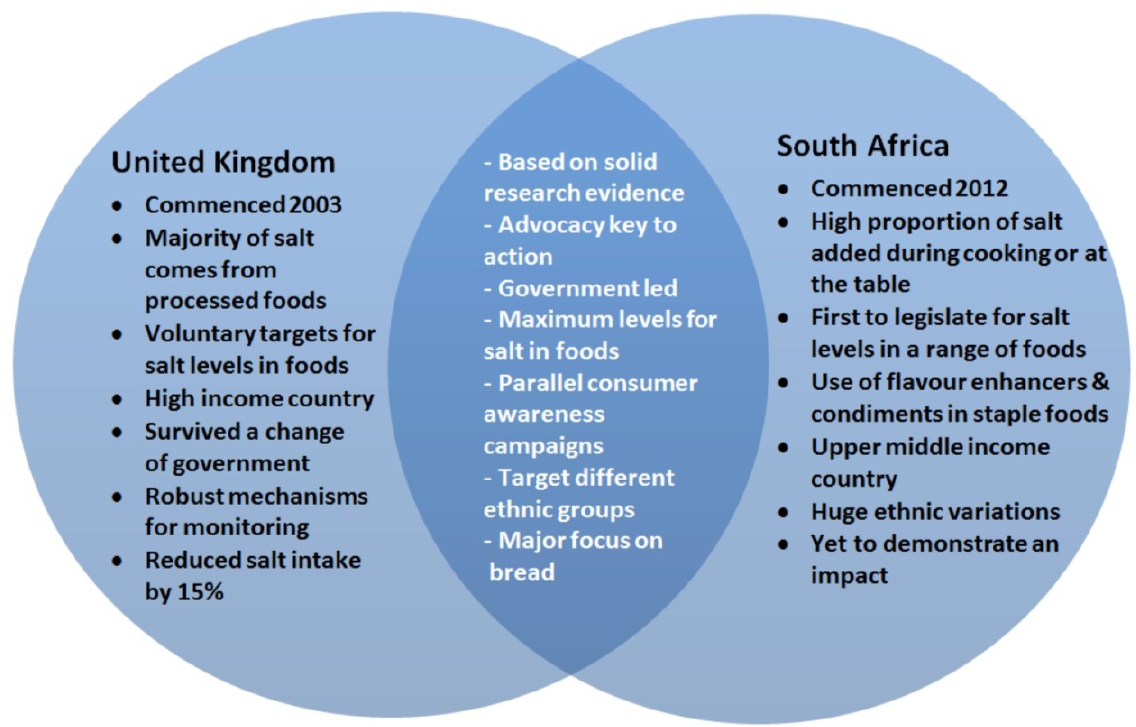
Figure 4. Venn diagram to show the similarities (areas of overlap) and differences between the UK and South African salt reduction strategies.